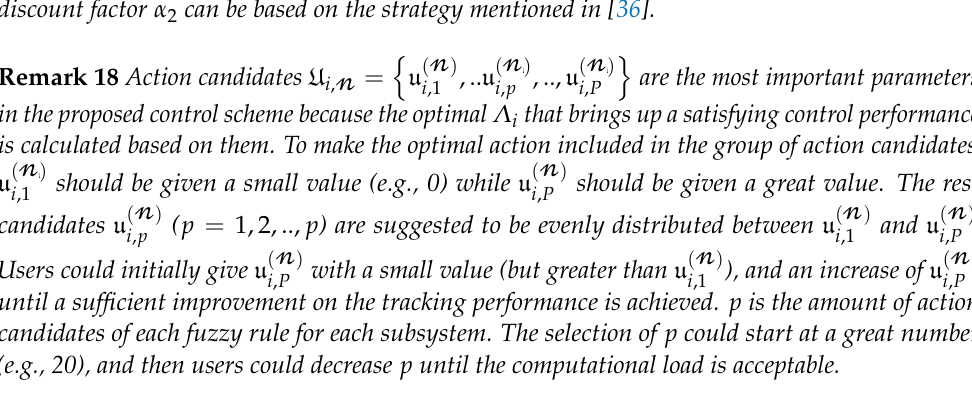
Figure 2. Membership function of fuzzy input of the 𝑖 (cid:3047)(cid:3035) subsystem. The parameters of membership function shown in Figure 2 are defined as follows: